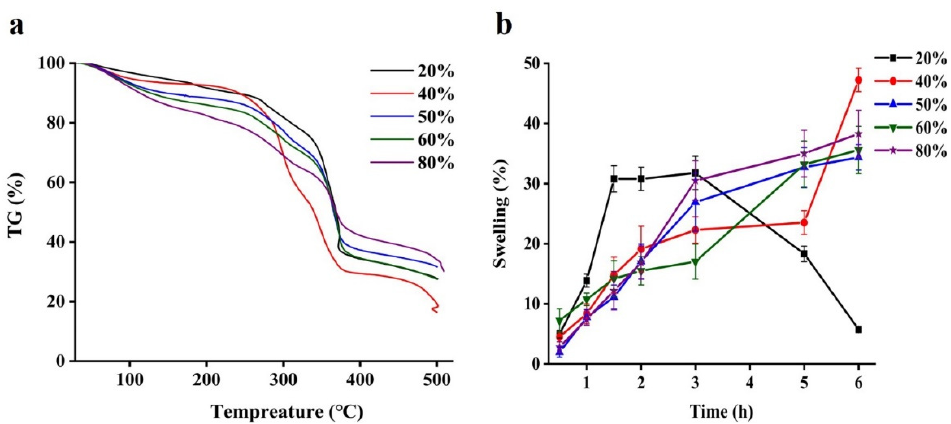
Figure 4. Thermogravimetric analysis curves ( a ) and water content ( b ) of quercetin-loaded beads with different content of pectin.